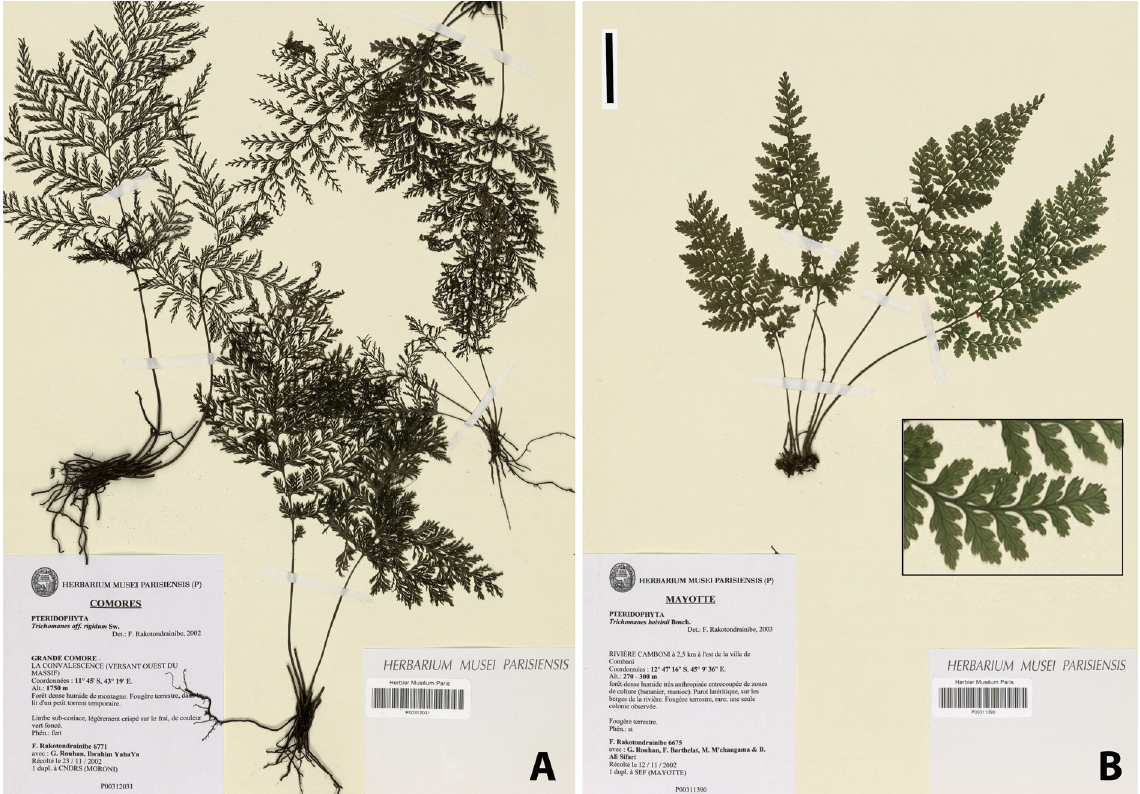
Fig. 4. Terrestrial Comorian Hymenophyllaceae. A . Abrodictyum pseudorigidum Bauret & Dubuisson, first identified as A. rigidum (Sw.) Ebihara & Dubuisson, ( F.Rakotondrainibe et al. 6771 , P00312031). B . Trichomanes boivinii Bosch, new for the archipelago according to the last inventories (as discussed in text) ( F.Rakotondrainibe et al. 6675 , P00311390). Scale bar for both species = 3